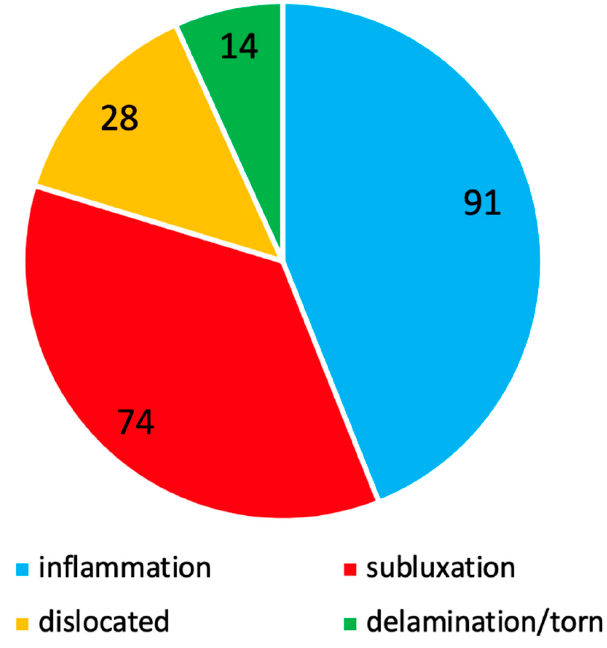
Figure 3. Biceps pathologies distribution. Considering all patients, active anterior forward flexion increased from mean 132.4° ± 33.9° (range, 10° to 180°) to 153.1° ± 20.6° (range, 80° to 100°) ( p < 0.00001), external rotation from 42.1° ± 19.3° (range 0° to 90°) to 49.3° ± 17.7° (range 0° to 90°) ( p < 0.00001), internal rotation from a median of L5/L3 (range, buttock to T12) to T12 (range, buttock to T12) ( p = 0.0124); Constant score from 54.3 ± 16.4 (range, 20 to 93) to 73.6 ± 12.5 (range, 28 to 100) ( p < 0.00001); pain (VAS) from 4.6 ± 1.9 (range, 0 to 9.7) to 1.3 ± 1.5 (range, 0 to 8) ( p < 0.00001) to 0.9 ± 1.4 (range, 0 to 6.3) ( p = 0.0001); SSV from 50.8 ± 17.6 (range, 5 to 90) to 77.4 ± 14.7 (range, to 30 to 100) at six months ( p < 0.00001) and to 88.5 ±13.1 at one year (range, 45 to 100) ( p < 0.00001). In 165 (79.7%) patients, repaired tendons were considered healed at six months; among 149 patients with single tendon tears, 121 repairs healed (81.2%), and among 58 patients with massive cuff tears, 44 (75.8%) repairs healed. Patients presenting LHB-related complications and relative rates of each complication at six months and one year, with relative p -value, were reported in Table 2. Table 2. LHB-related complications. LHB Related Complications